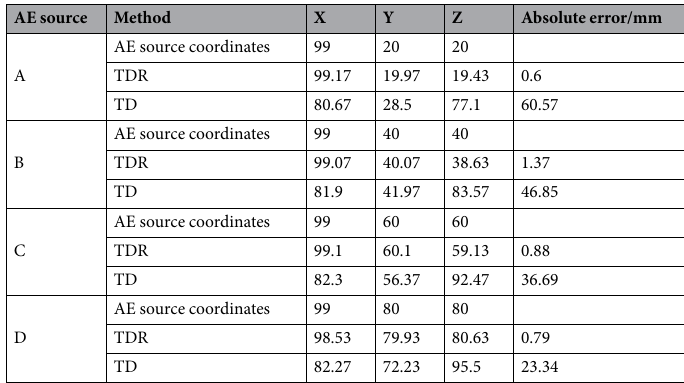
Table 1. The results of the new and traditional methods in a 3D locating test.